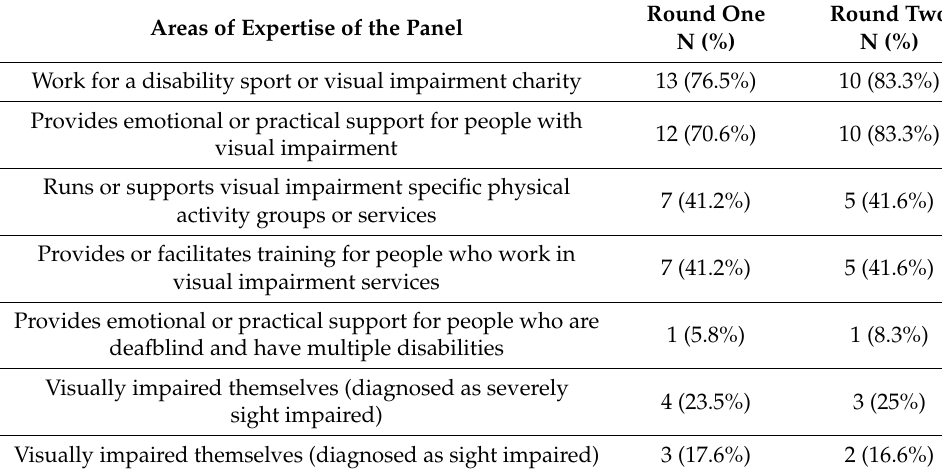
Table 1. Areas of expertise of the panel in round